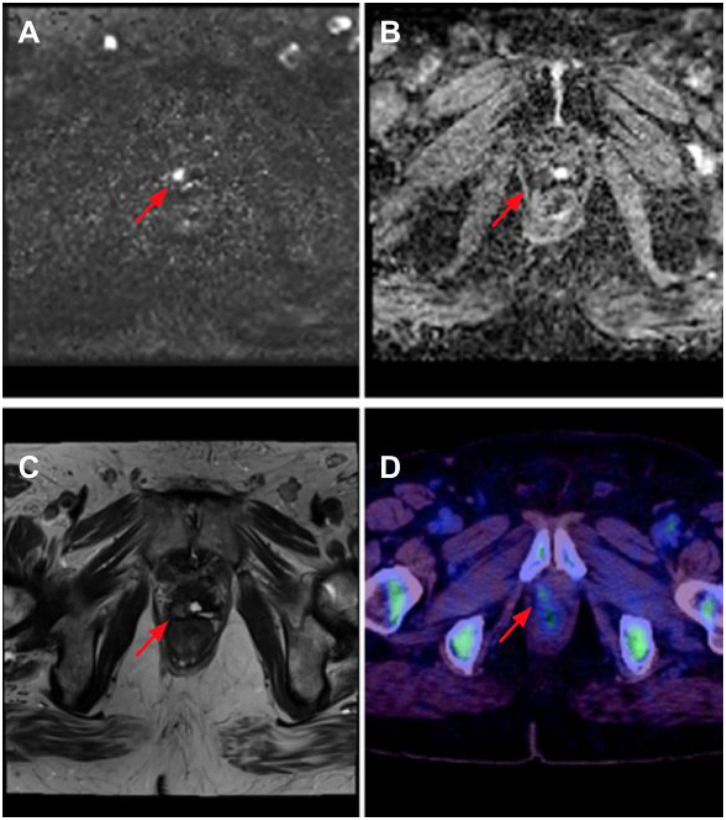
Right anterior prostate bed recurrence as seen on multi-parametric MRI (mpMRI) with 18F-fluciclovine PET/CT. There is diffusion signal on calculated b-1400 diffusion-weighted imaging (DWI) (red arrow) (A) with corresponding low apparent diffusion coefficient (ADC) values (red arrow). (B) Anatomical correlation is noted on T2 Half-Fourier acquisition single-shot turbo spin echo (HASTE) imaging (red arrow). (C) Lesion is confirmed to contain upregulated amino acid transport, seen in prostate cancer, in the 18F-fluciclovine image (red arrow) (D).